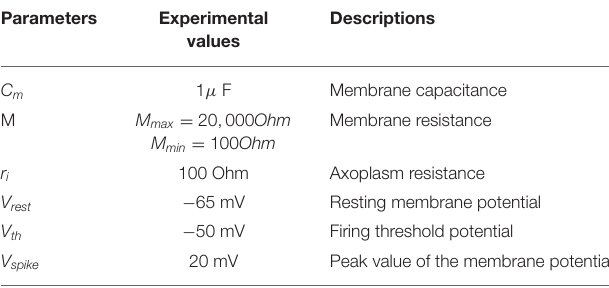
TABLE 1 | The parameters of the MLIF cable